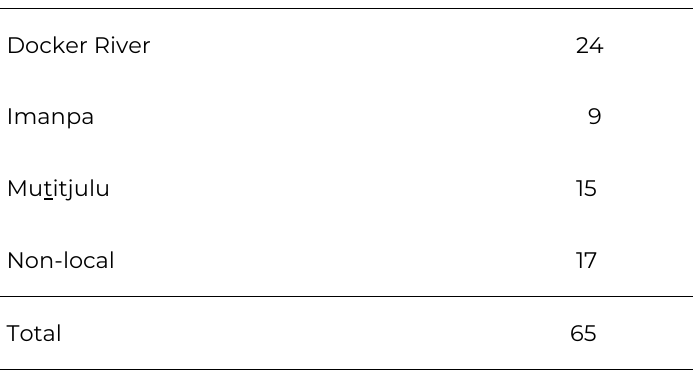
Table 3. Participants’ home community Participants’ home